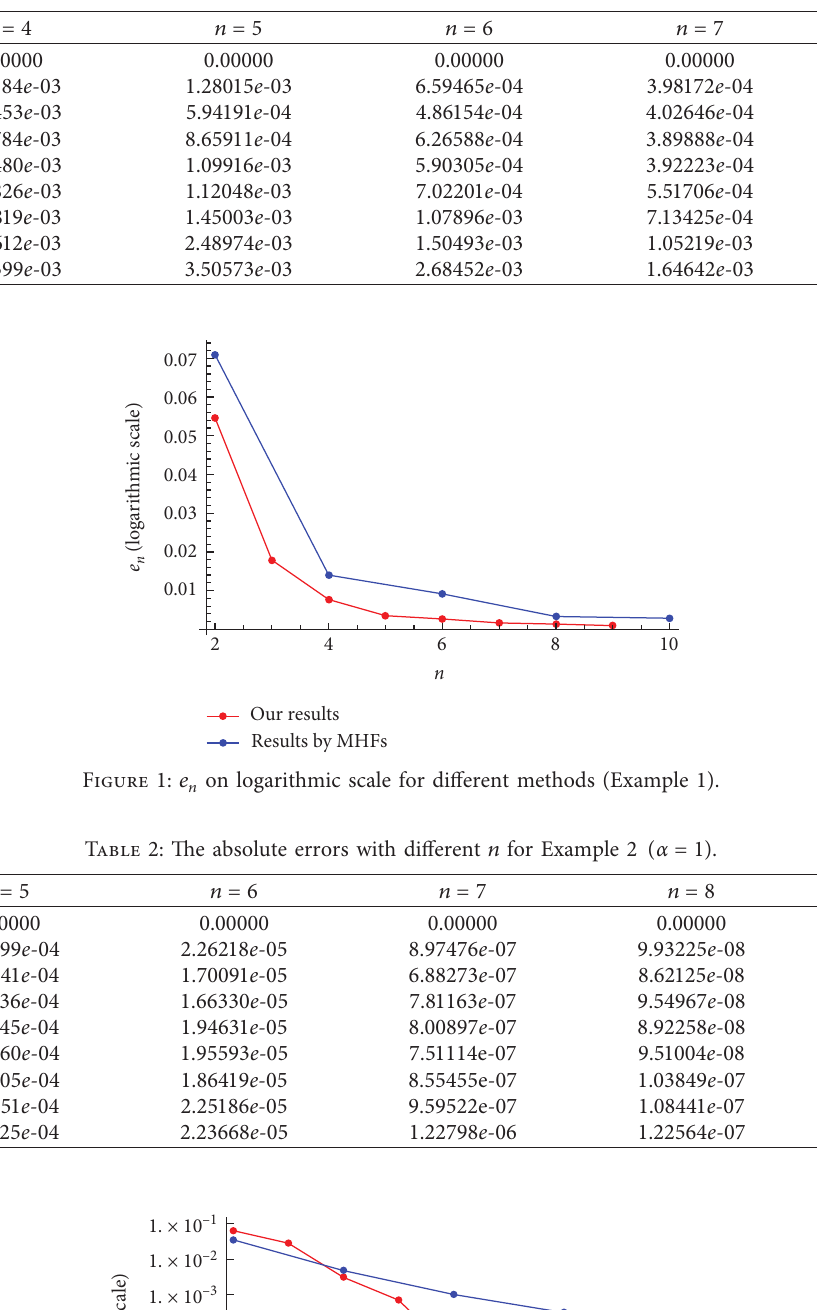
Table 1: The absolute errors with different n for Example 1.